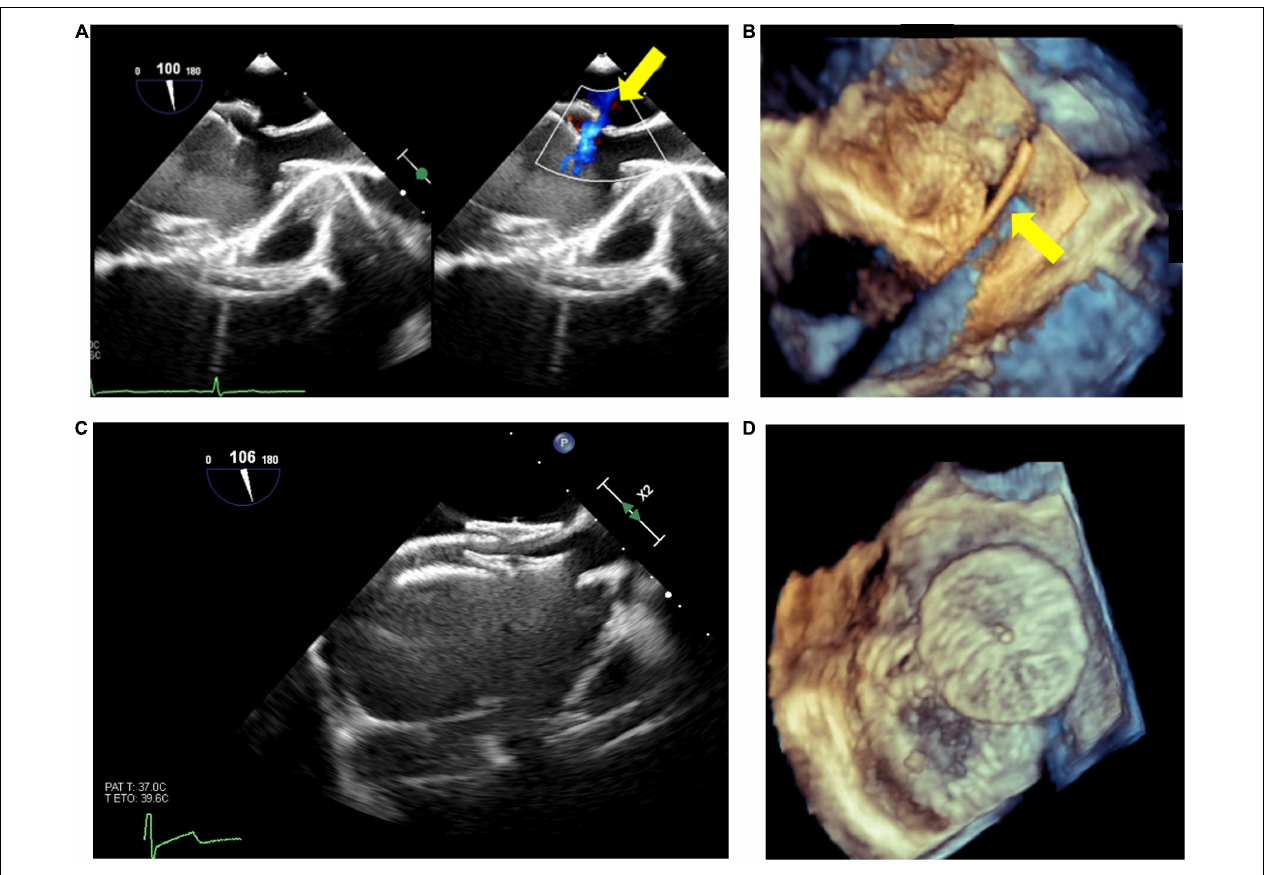
FIGURE 1 | Atrial septal defect (ASD) closure with two devices. Residual ASD (yellow arrow) after device release (A) ; live 3D echo showing the guidewire passage (yellow arrow) through the residual defect (B) ; 2D visualization of the devices (C) ; 3D visualization of devices position and shape (D)